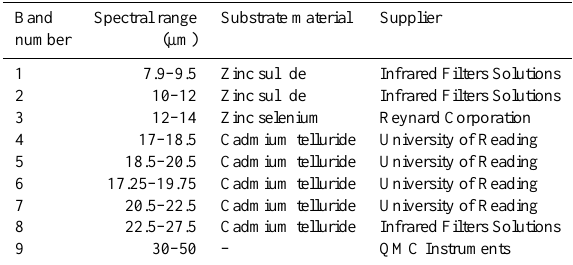
Table 1. Filters spectral